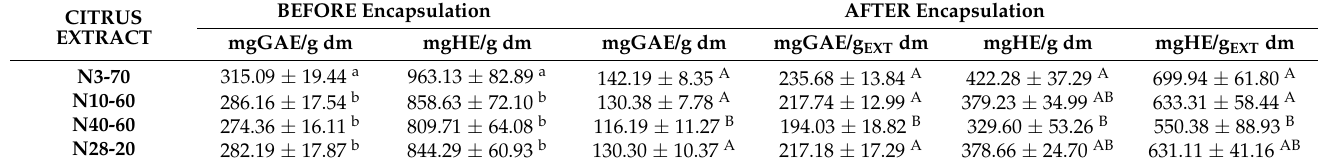
Table 3. Total phenolic content (GAE gallic acid equivalents, HE hesperidin equivalents) of the citrus extract before and after encapsulation with β -CD. Values reported on powder (g) or on extract (EXT) dry matter (dm) as mean ± standard deviation. Lowercase letters indicate comparisons between initial commercial extracts, while uppercase letters indicate comparisons between the encapsulated